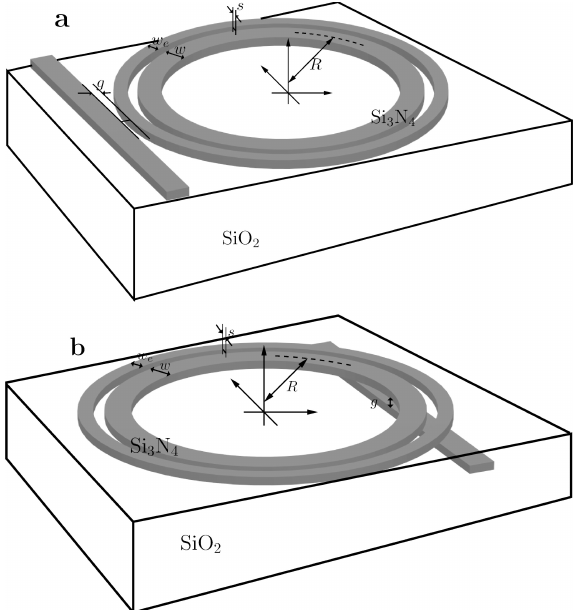
Figure 1. Concentric nonsymmetric microring-sensing geometry displaying ( a ) side coupling and ( b ) bottom coupling to the access